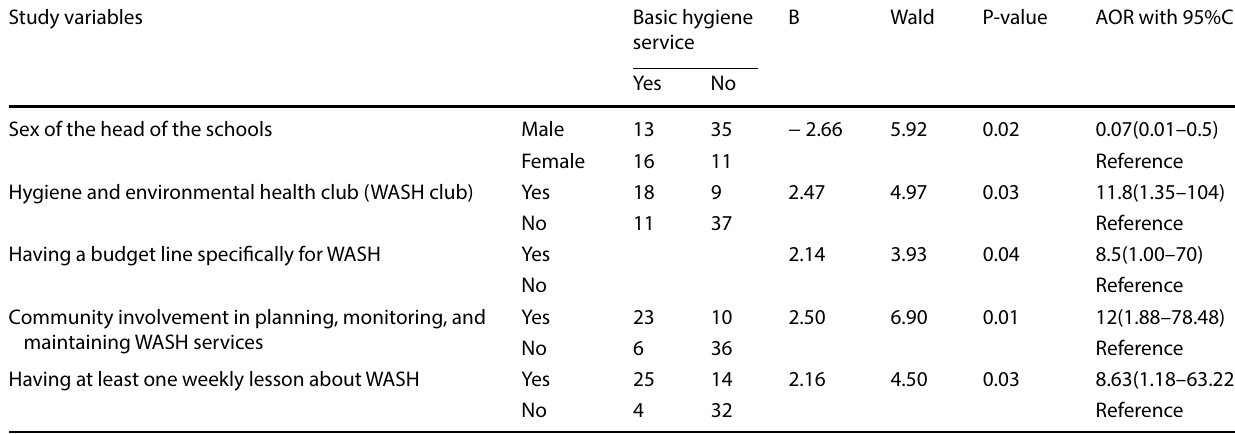
Table 4 Multivariable logistic regression analysis (n =